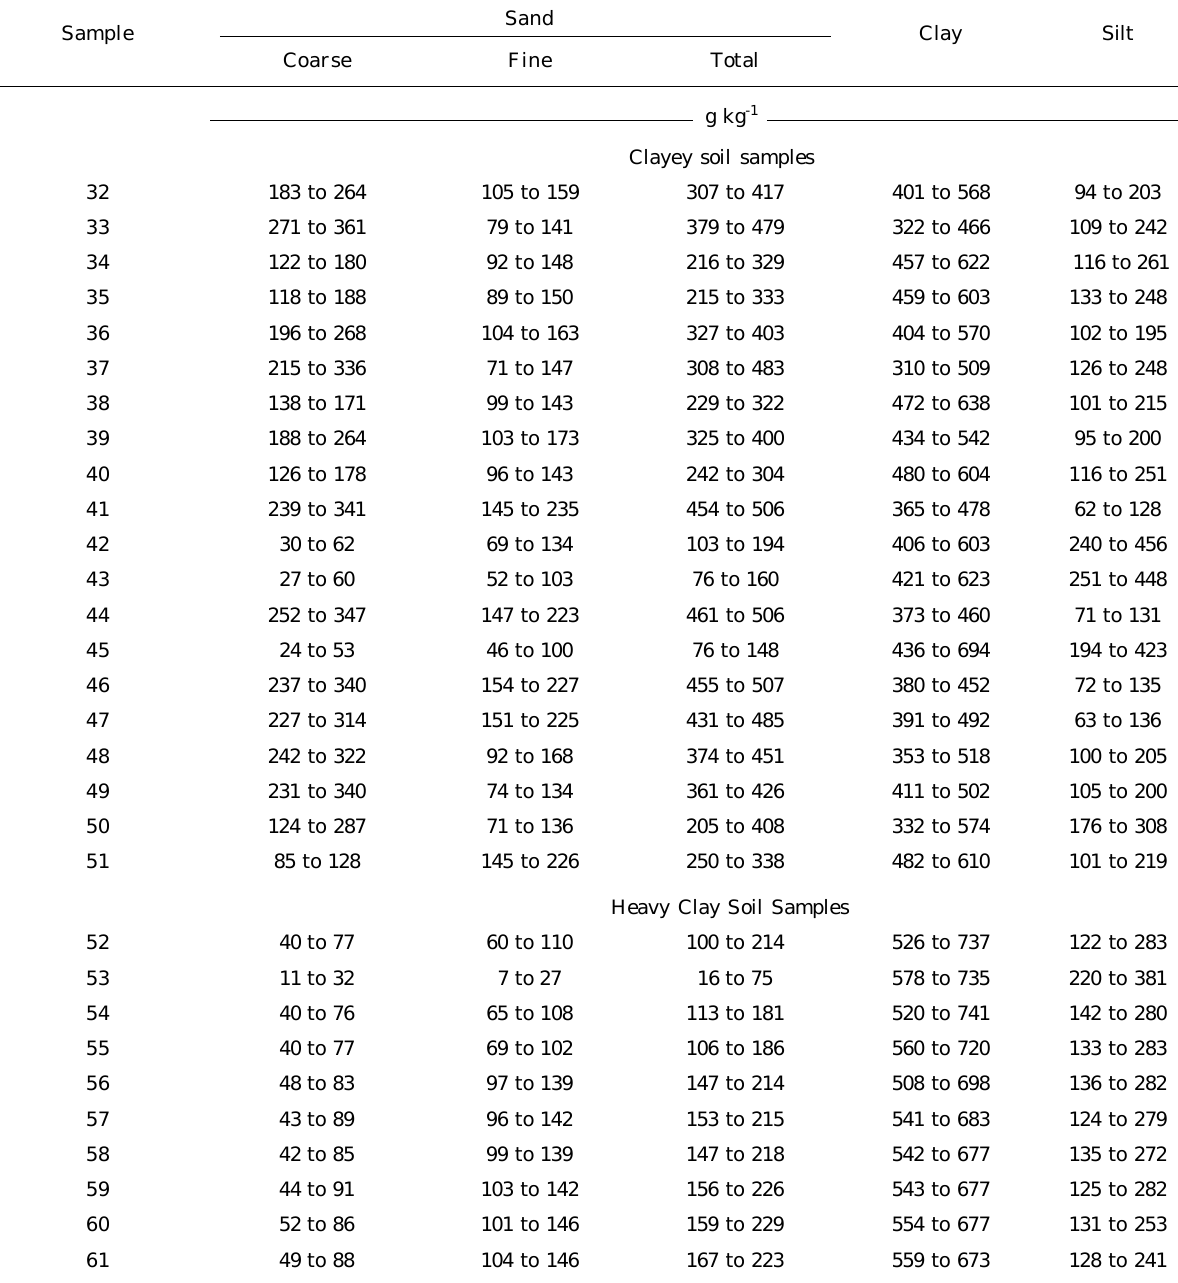
Table 2. Confidence intervals for coarse sand, fine sand, total sand, silt and clay contents for 20 Clayey soil samples and for 10 Heavy Clay soil samples